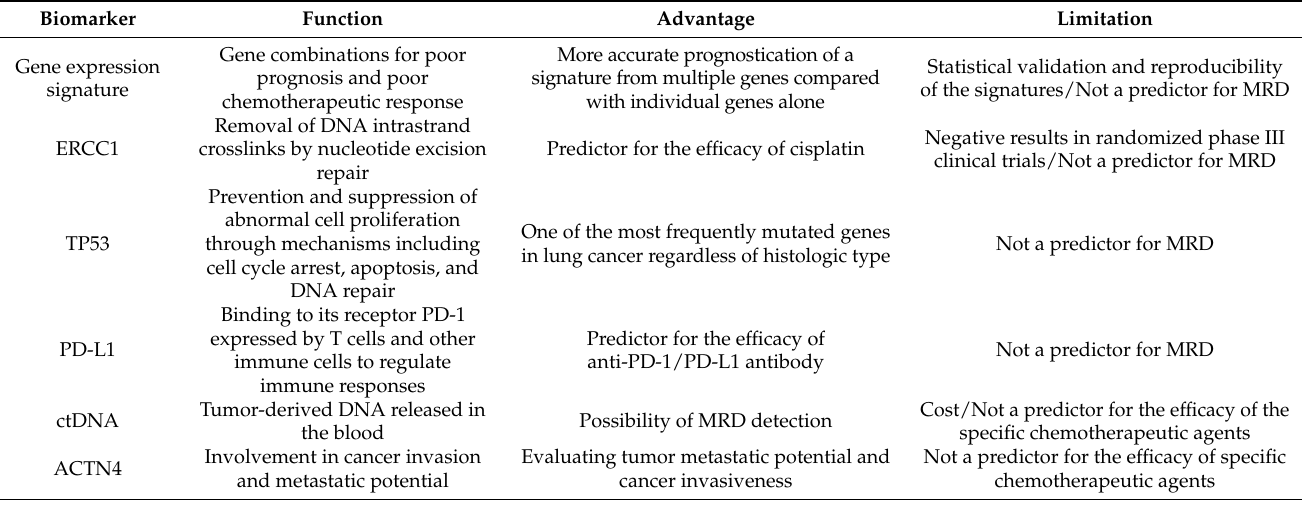
Table 2. Advantages and limitations of perioperative biomarker